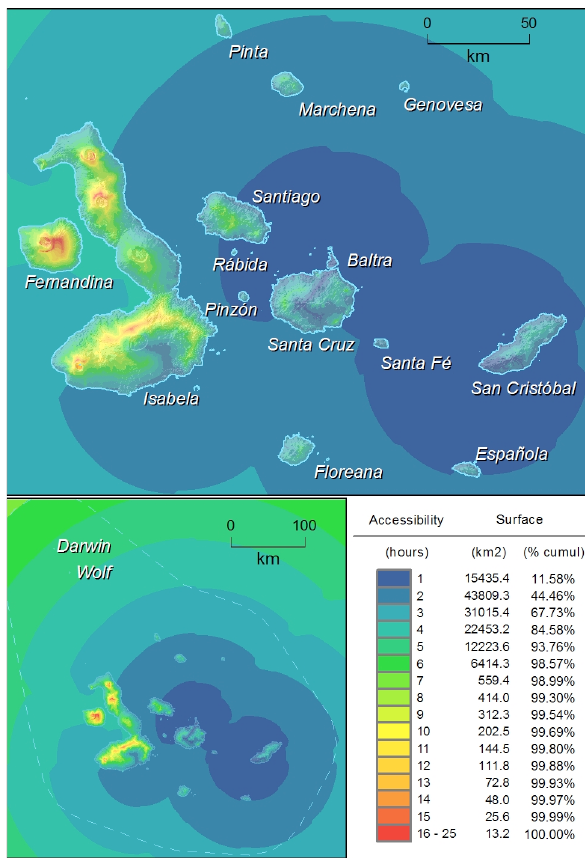
Figure 3. Accessibility and isolation of the Galápagos Islands Islands in Group 1 (Santa Cruz, San Cristóbal, Santa Fé, Pinzón and Española) are easy to reach and most of their area is accessible in little time (mnAc < 1h and MeAc < 2.2h). The most isolated areas of these islands are at no more than 6.3h central area of the archipelago towards South-East.